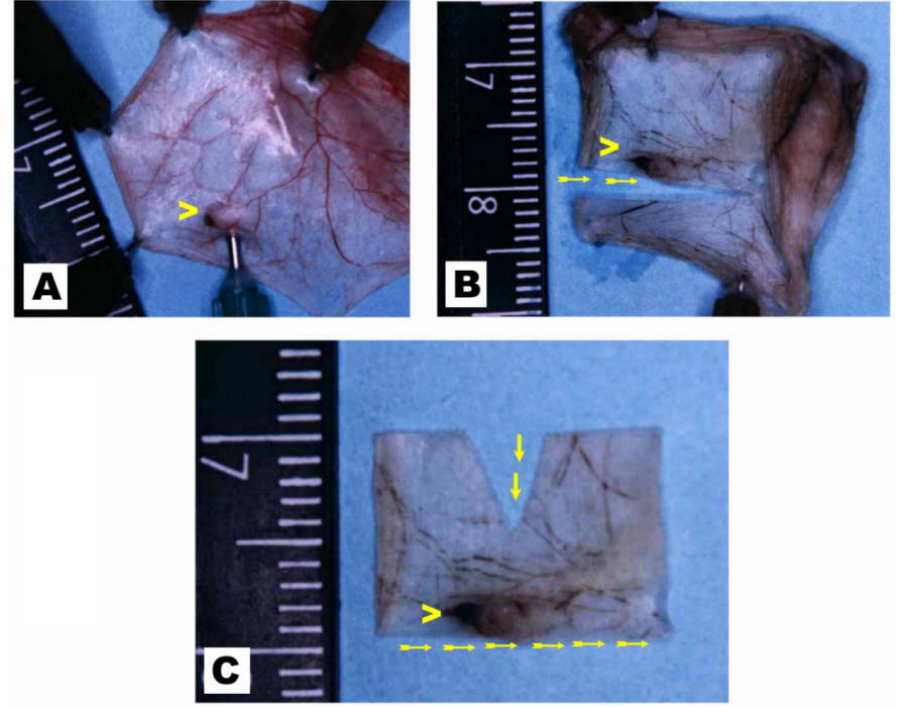
FIGURE 4 – Standardization adopted for samples preparation for the histological